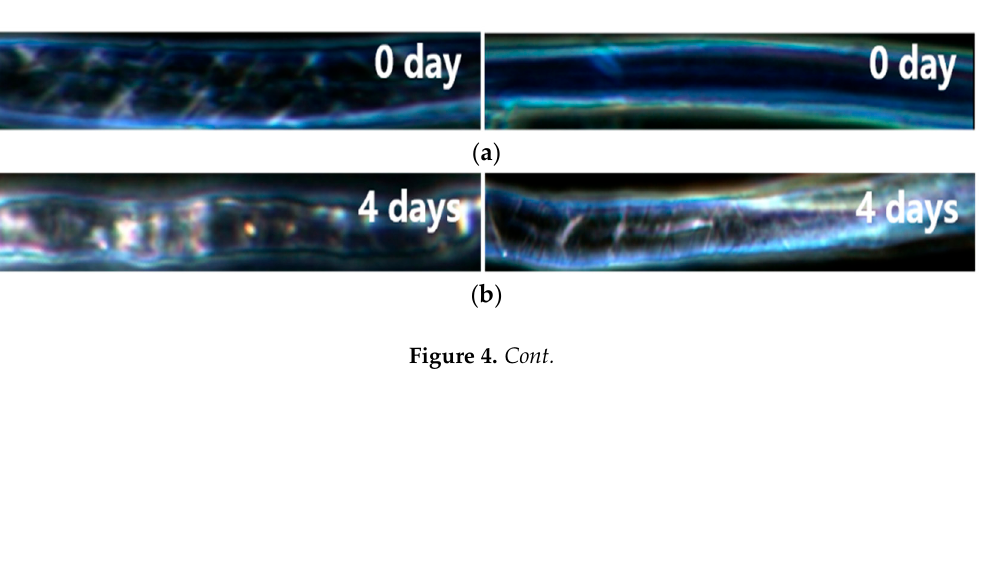
Figure 3. Fiber morphology at different aging times.